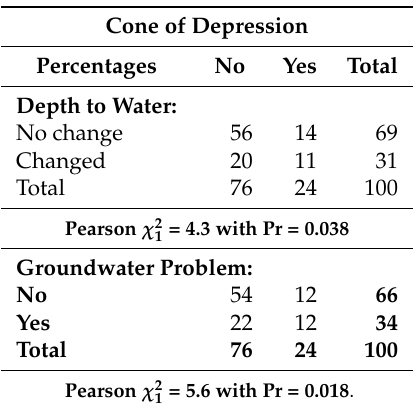
Table 5. Aquifer “cone of depression” and farmer perceptions and